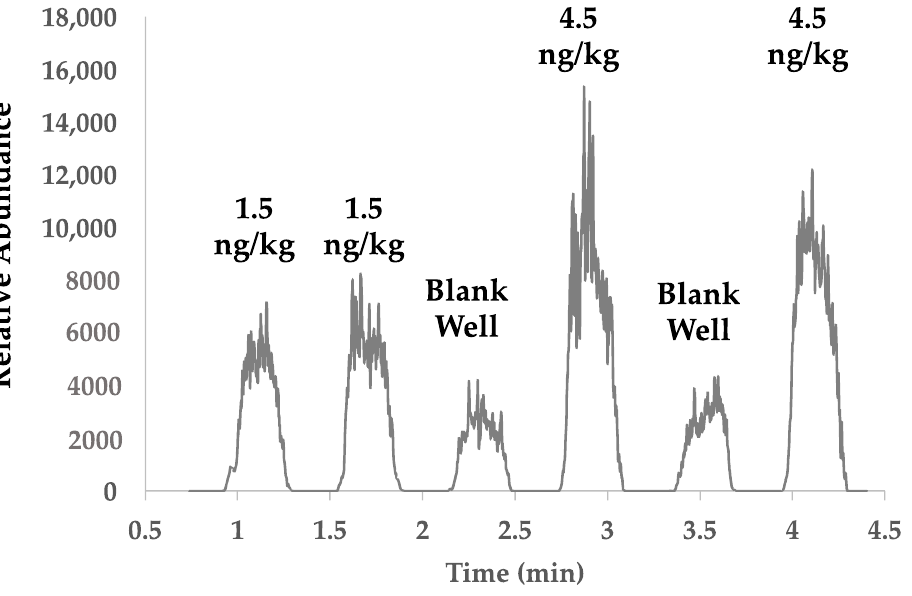
Figure 6. DART-QqQ-MS/MS selected ion chronograms for IBMP ( m/z 167.4 ➔ m/z 124.1) at 1.5 ng/kg in Vitis vinifera (cv. Barbera) grape homogenate with no detectable IBMP as previously determined by HS-SPME-GCMS. Wells 1 and 2 are analytical replicates spiked with IBMP at 1.5 ng/kg, wells 4 and 6 are spiked with IBMP at 4.5 ng/kg, and wells 3 and 5 are blank wells.